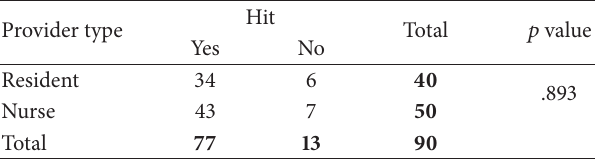
Table 1: Relationship between provider type and success (hit) at ultrasound guided IV access.